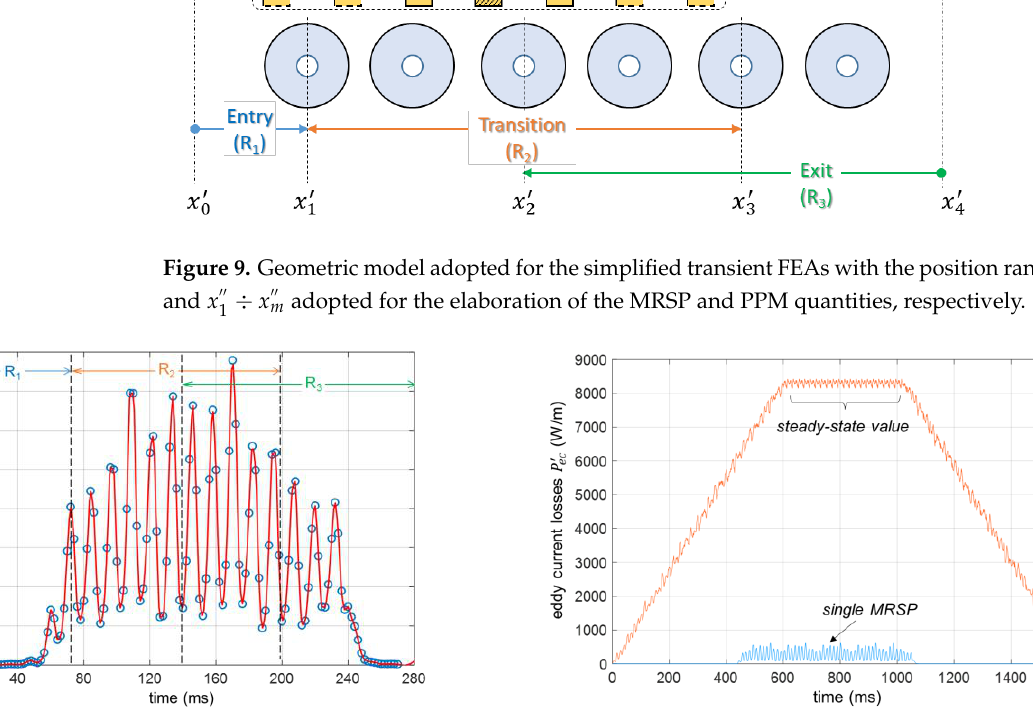
10 of 17 dergoes the same thrust and electromagnetic losses, albeit time shifted. The same deduc- tion applies to each PPM yoke region. Then, the analysis can be restricted to a single MRSP and PPM yoke section, provided that the electromagnetic effects on MRSPs during their motion in the entry and exit regions as well as in the intermediate zone (transition) be- tween RPMCs and PPMs are reproduced with acceptable accuracy. ( a ) ( b ) ( c ) ( d ) Figure 8. Maps of the electromagnetic quantities determined by the FEAs (same MR position); eddy current density ( a ), flux lines ( b ), and flux density ( c ) evaluated by the transient solver; flux density evaluated by the magnetostatic solver ( d ). To this purpose, the reduced model in Figure 9 is considered, consisting of three RPMC modules and an odd subset 𝑛 𝑠′ of MRSPs, moving across the RPMC modules. Even if the magnetic field distribution is evaluated on the whole model, only the results related to the reference objects (identified by hatching) are post-processed. In particular, the instantaneous thrust and losses are calculated only for the middle MRSP of the subset